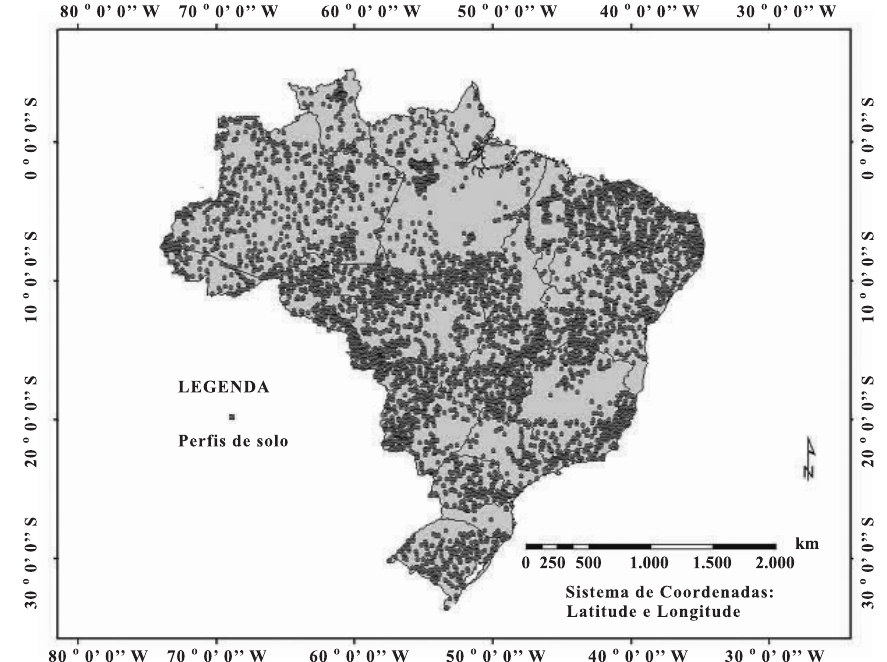
Figura 1. Mapa do Brasil com a divisão estadual e a distribuição espacial dos perfis de solo que integram o banco de